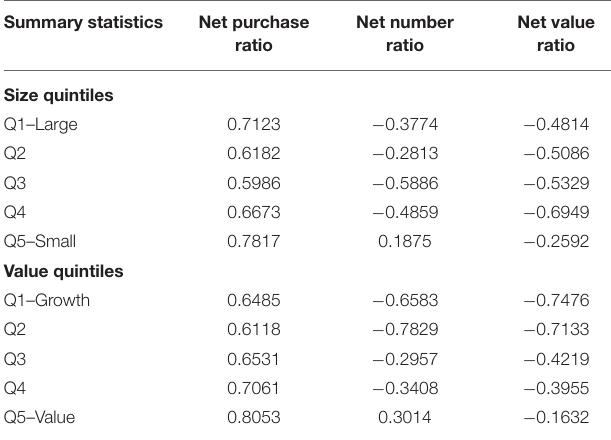
TABLE 4 | Size and value